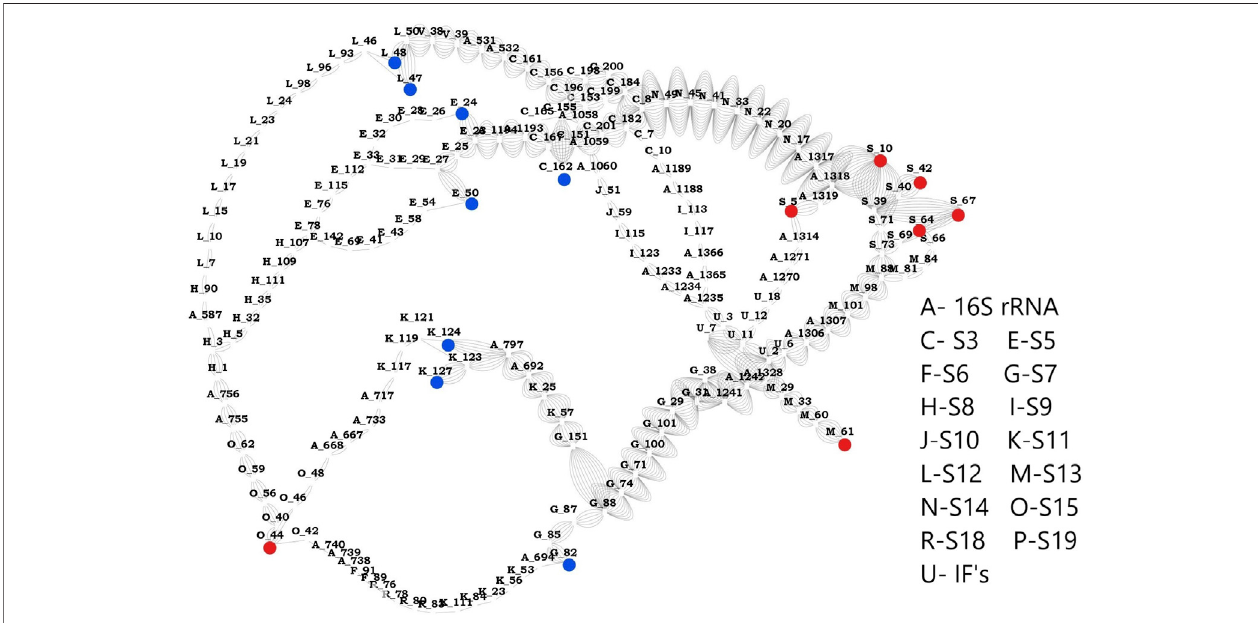
FIGURE5| Networkbetweensensorsandeffectors.Thisimageshowstheshortestpathcomputedbetweentheidenti fi edsensorsandeffectors.Sensorresidues are marked in blue and effector residues in red. Protein names are represented using alphabets and their respective names are shown in the legend. Number of edges between any two nodes represents number of times that edge is crossed between sensors and